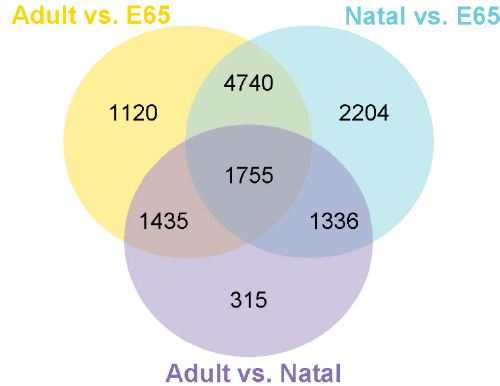
Figure 3. Presentation of the DE genes (DEGs) numbers amid the three groups of pairwise correlation in Venn diagram form.